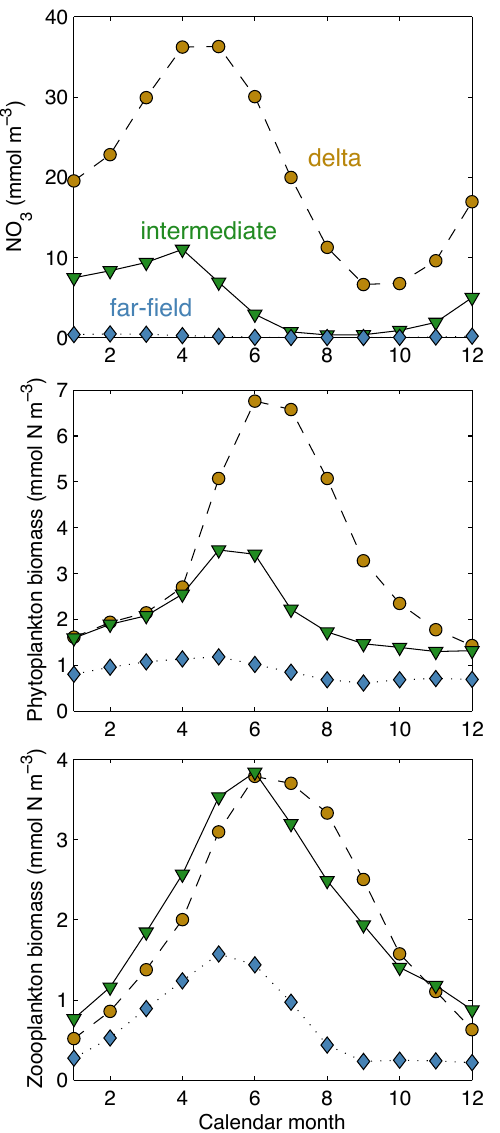
Fig. 11. Climatological monthly means of simulated mixed layer depth (top) and surface salinity (bottom) for the delta, intermediate and far-field regions (see Fig. 1).